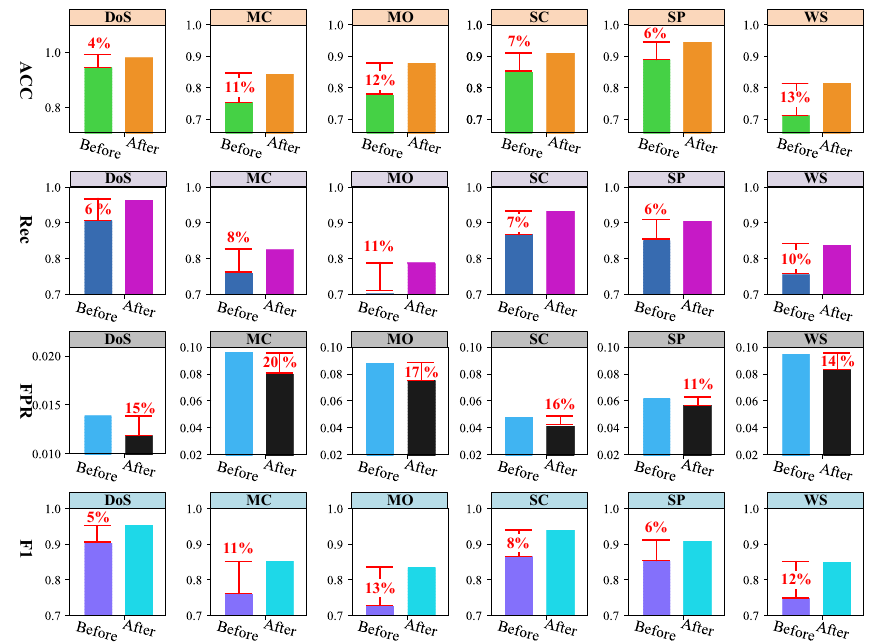
Figure 7. Performance analysis of two optimization strategies on DS2OS dataset.